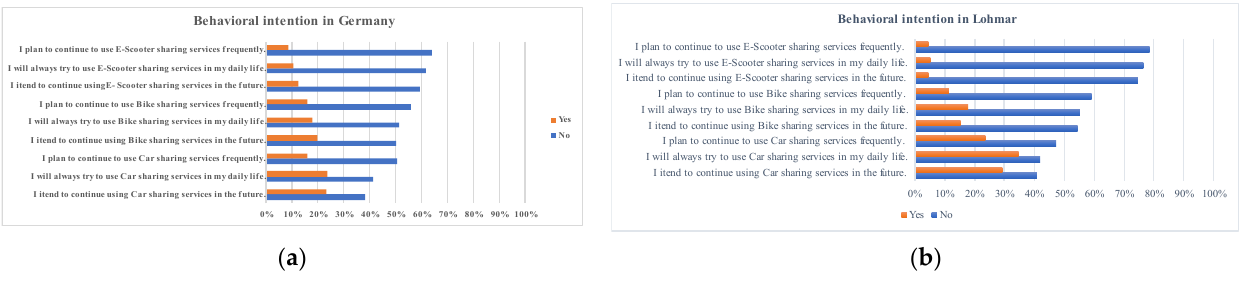
Figure 7. Behavioral Intention (BI): ( a ) Germany vs. ( b ) Lohmar.